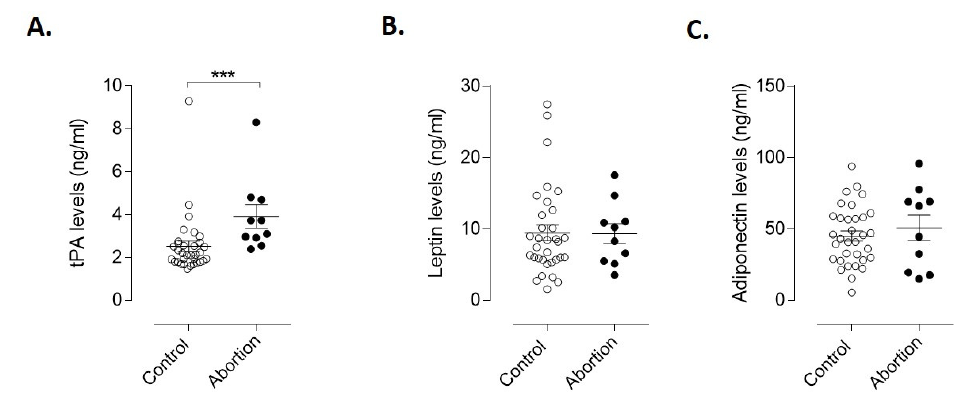
Figure 3. Concentration of endothelial and adipogenic markers in plasma of controls and spontaneous abortion patients. ( A ) Mean concentration of tPA, ( B ) leptin and ( C ) adiponectin present in plasma from controls ( n = 33) and spontaneous abortion ( n = 10). Statistical analyses were performed using the Mann–Whitney test. Results are the mean ± SEM. *** p ≤ 0.001, significant. tPA, tissue-type plasminogen activator.